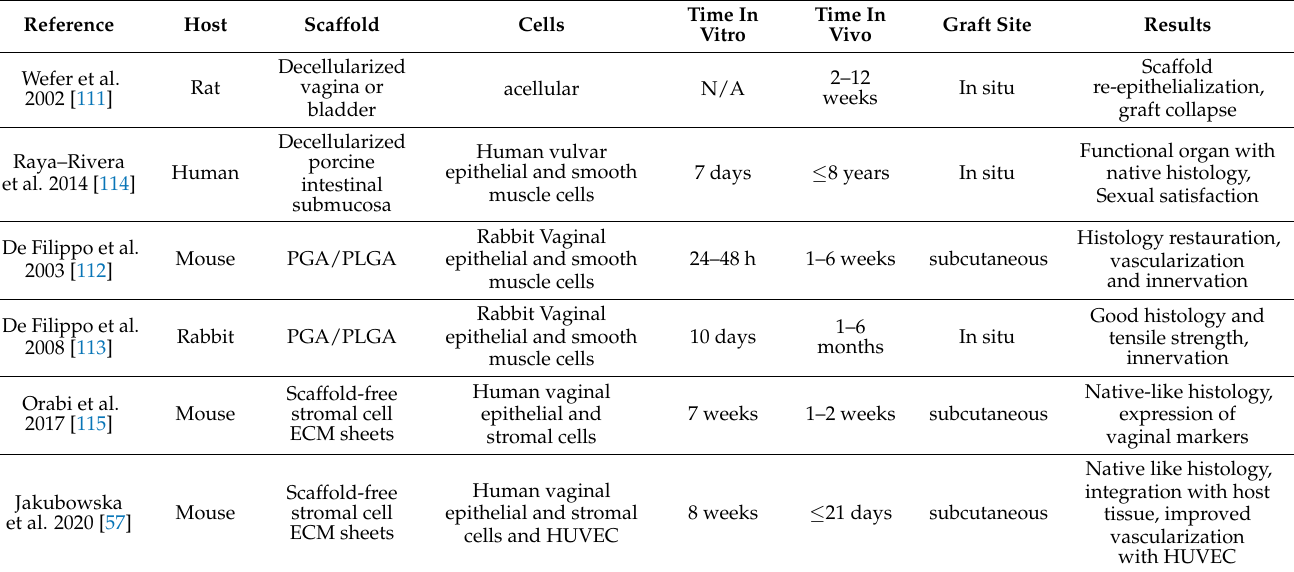
Table 3. Summary of tissue-engineering vagina models in